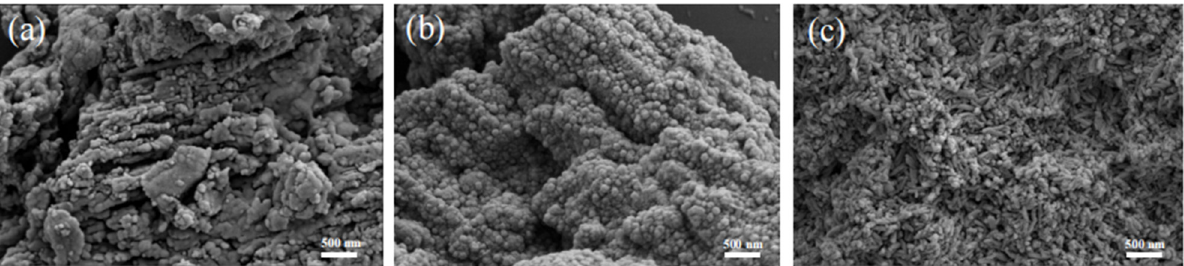
Figure 1. SEM images of g-C 3 N 4 ( a ), tri-C 3 N 4 ( b ), and tri-s-tri-C 3 N 4 ( c